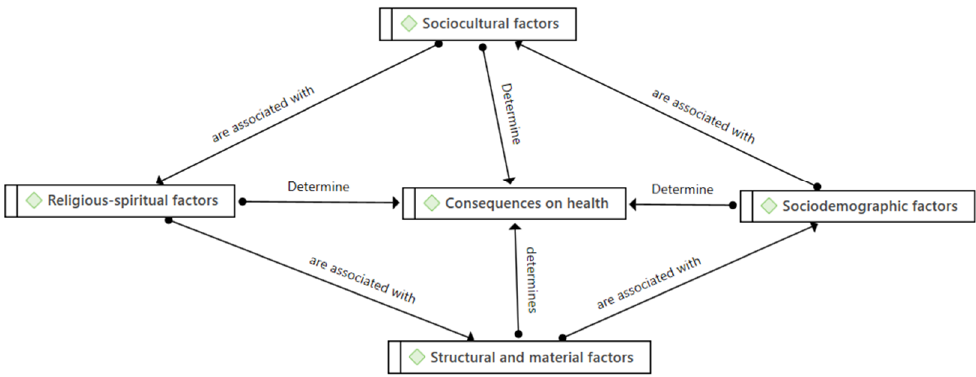
Figure 1. Health conditioning factors. Source: Prepared by the authors.